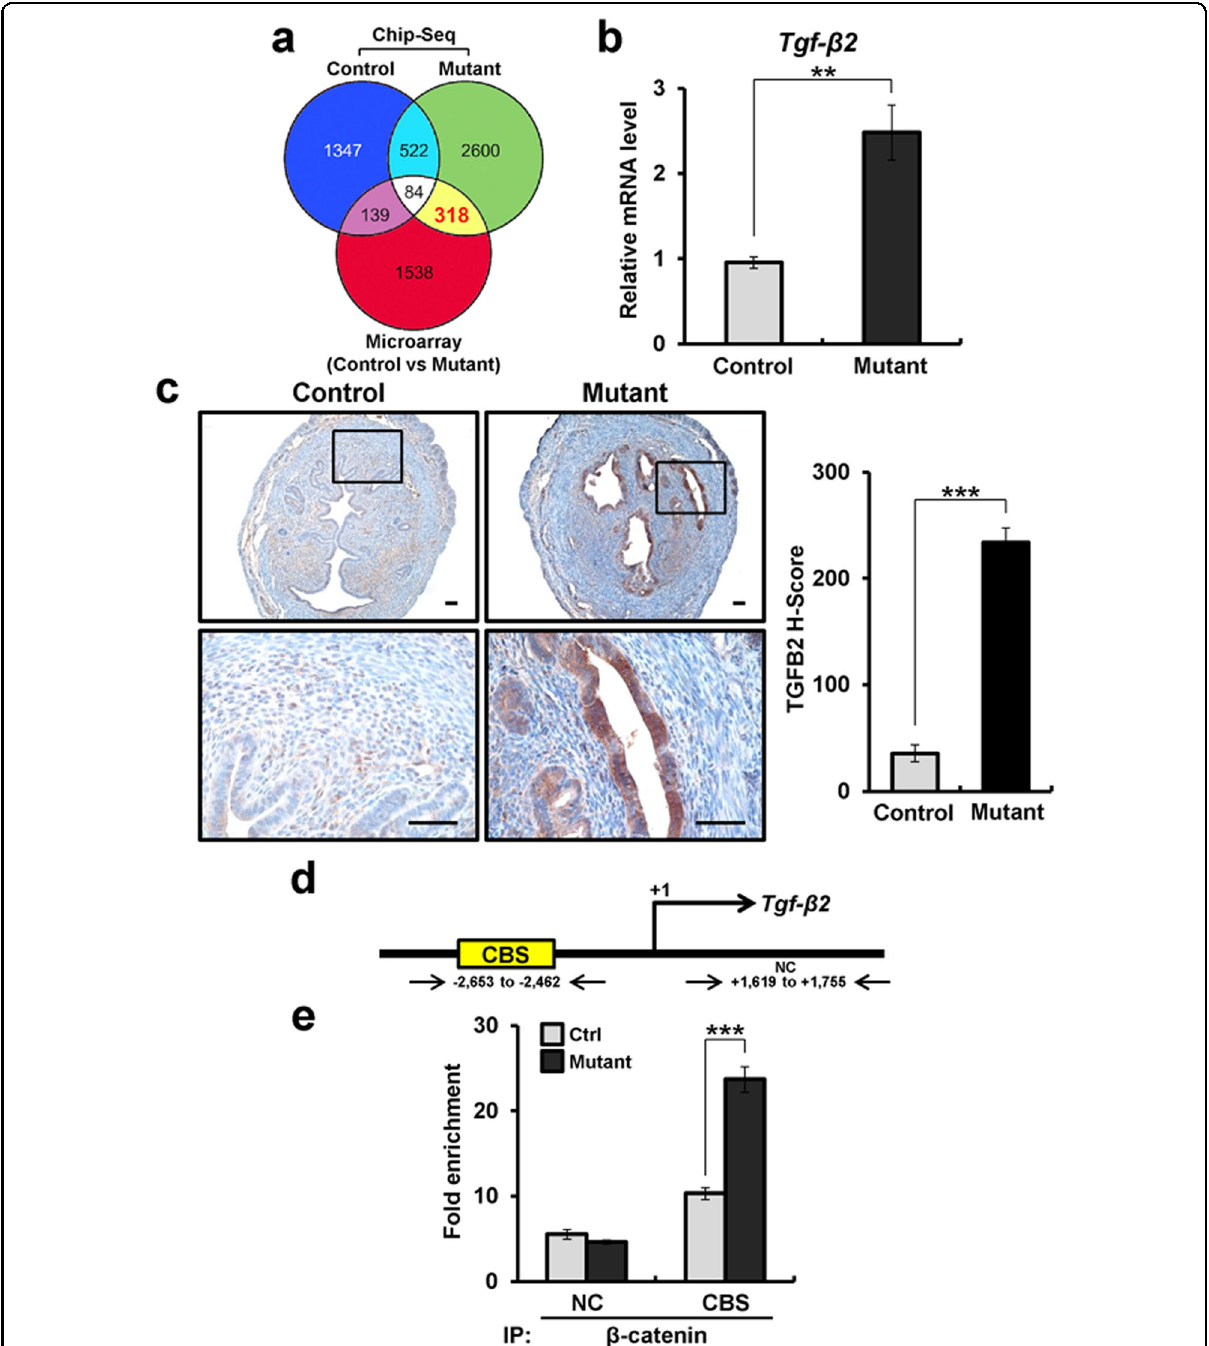
Fig. 1 Identi fi cation of Tgf- β 2 as a target gene of β -catenin in the murine uterus. a Venn diagram illustrating the overlap between nonredundant genes bound by β -catenin as determined by ChIP-seq and those genes regulated by β -catenin by transcriptomic analysis (>1.5-fold) in control and mutant mouse uteri. b Quantitative real-time PCR analysis of Tgf- β 2 in the uterus of control and mutant mice at 4 weeks of age ( n = 3 per genotype). c Representative photomicrographs and histological score (H-score) of TGF- β 2 immunohistochemical staining in uteri of control and mutant mice at 4 weeks of age ( n = 5 per genotype). Scale bars represent 50 μ m. d Map of the β -catenin-binding site (CBS) and negative control (NC) on the Tgf- β 2 promoter. e ChIP assay using the anti- β -catenin antibody on the Tgf- β 2 promoter in control and mutant mouse uteri at 4 weeks of age ( n = 3). The results represent the mean ± SEM. ** p < 0.01 and *** p <